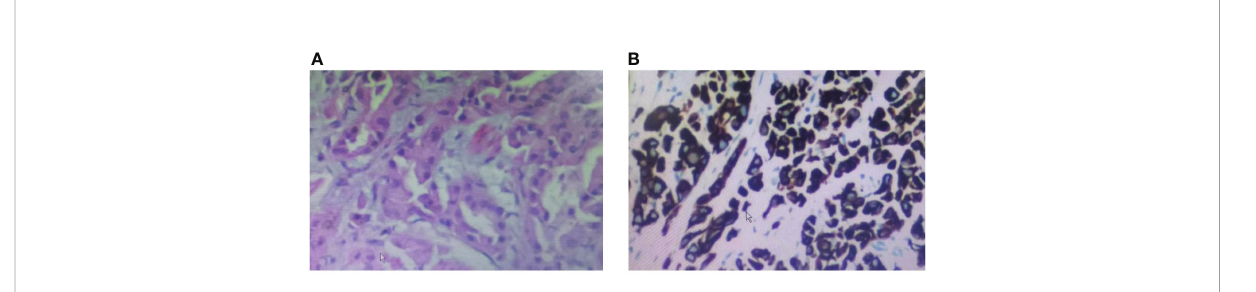
FIGURE 1 Biopsy pathology of a tumor of the lung lesion. (A) HE staining of the patient ’ s lung lesion, (B) IHC staining of the patient ’ s lung